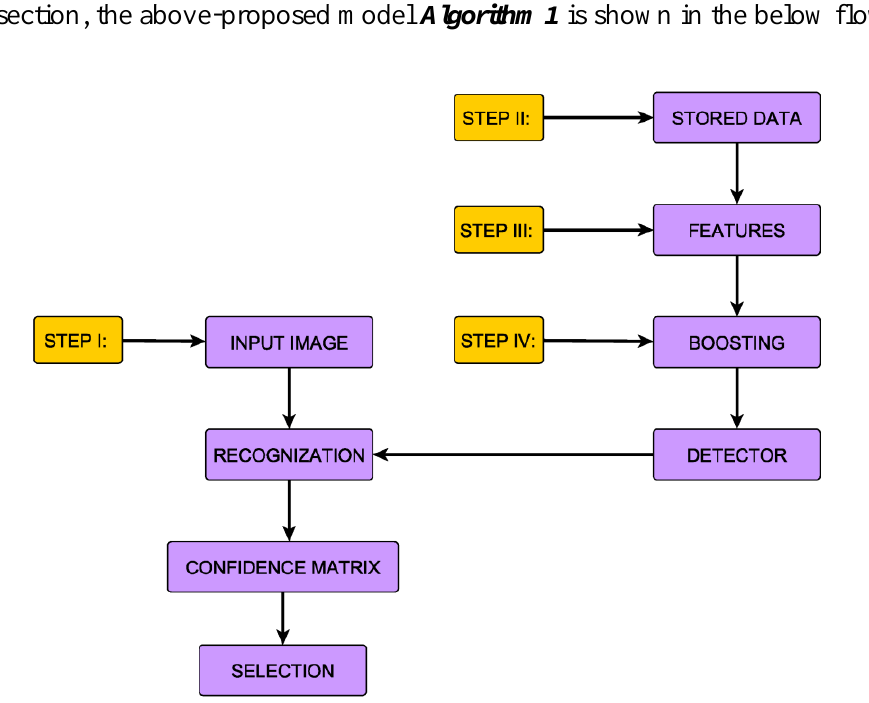
Figure 3. Flow chart for the proposed